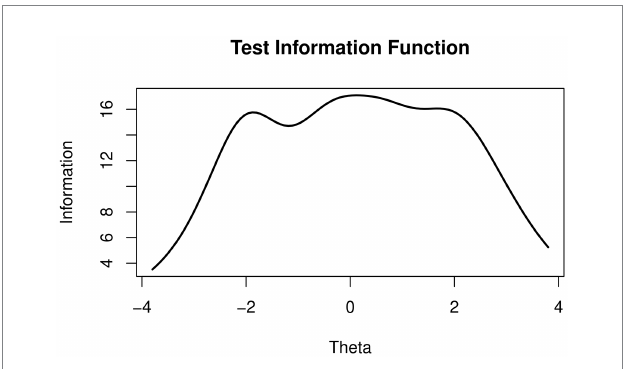
FIGURE 4 Test information curve of hepatitis B virus infection-related stigma scale (HBVISS).